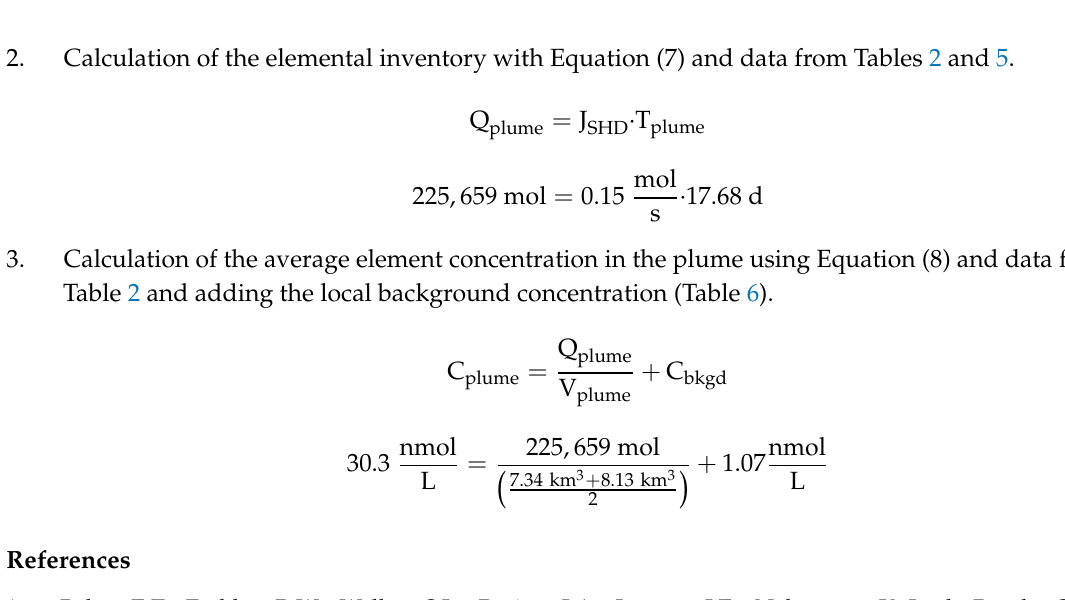
2. Calculation of the elemental inventory with Equation (7) and data from Tables 2 and 5.